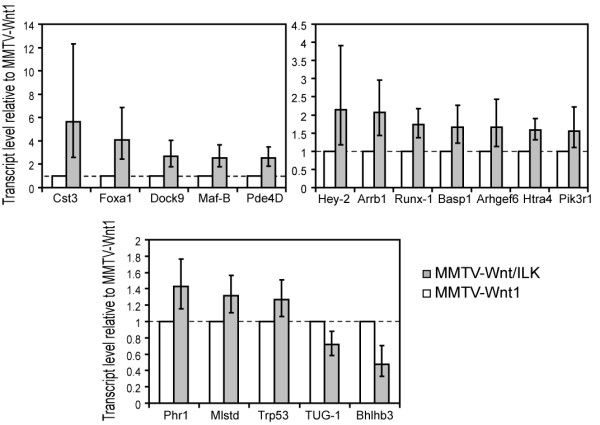
Q-RT-PCR validation of the microarray data shows differential expression of 17 of 26 genes tested (at least three and up to eight samples). Results were exponentiated to obtain natural-scale fold-change estimates (that is, 2-ΔΔCt) and 95% confidence intervals, shown as bar heights and whiskers, respectively. The genes that showed a fold change of ≥ 30% with P ≤ 0.05 are presented as validated genes.